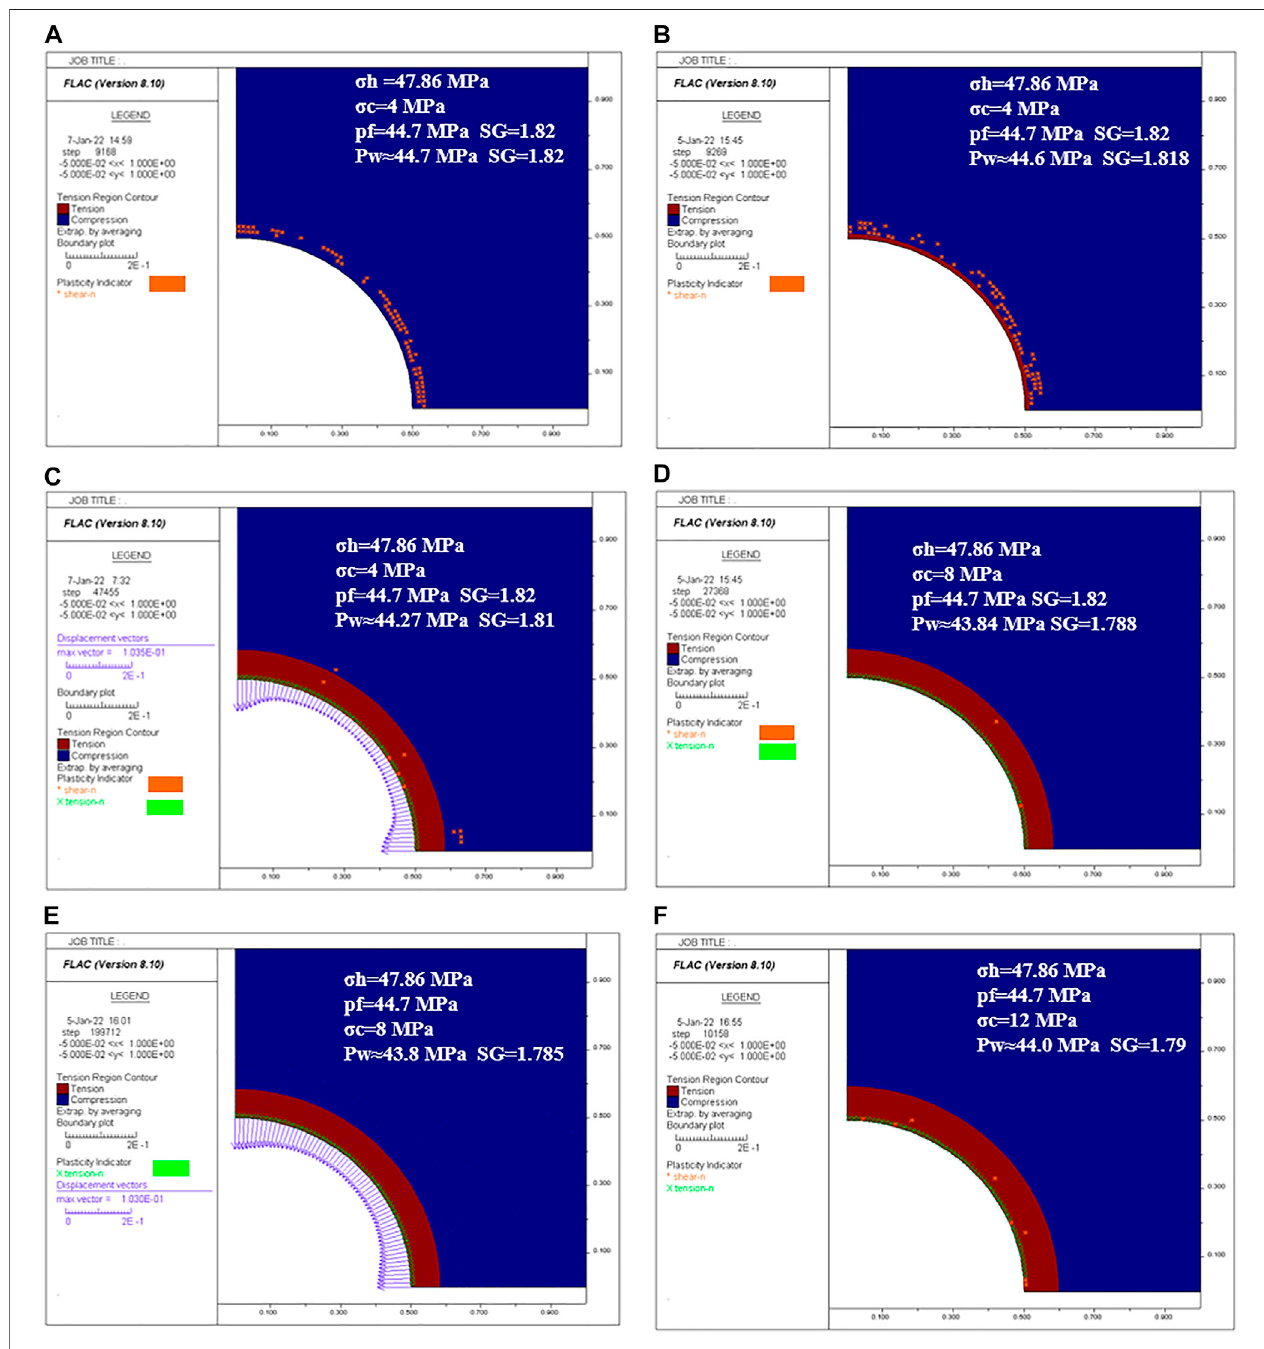
FIGURE 12 | Results of the numerical simulations performed with